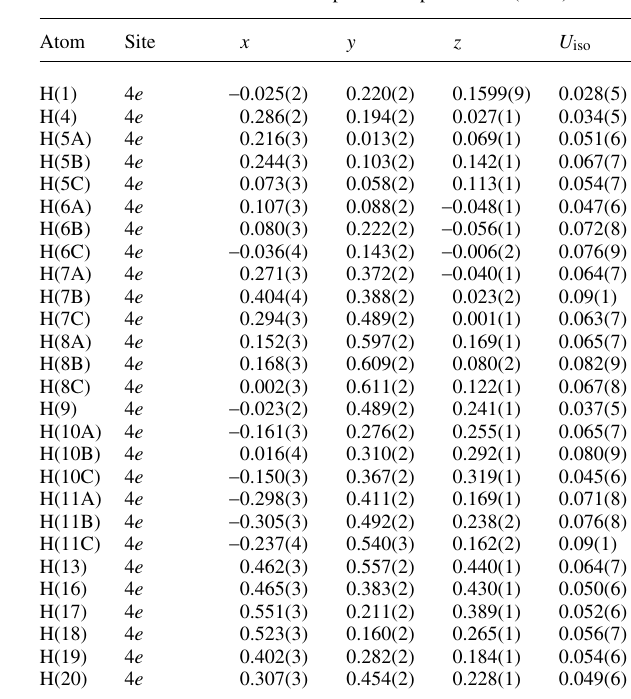
Table 2. Atomic coordinates and displacement parameters (in Å 2 )